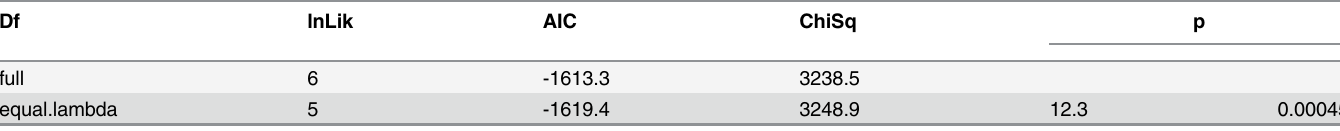
Table 3. Likelihood ratio test between the model of increased diversification of nymphalids feeding on Solanaceae against a model forcing equal speciation rates (no effect on